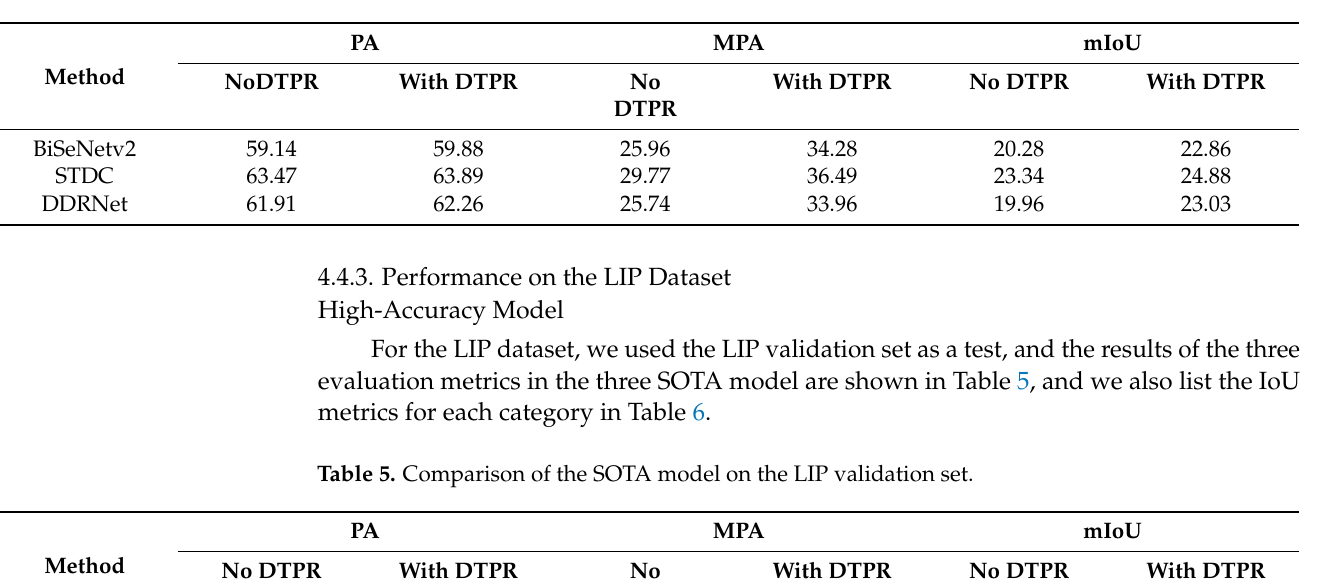
Table 4. Comparison of the real-time model on the MHPv2.0 validation set.